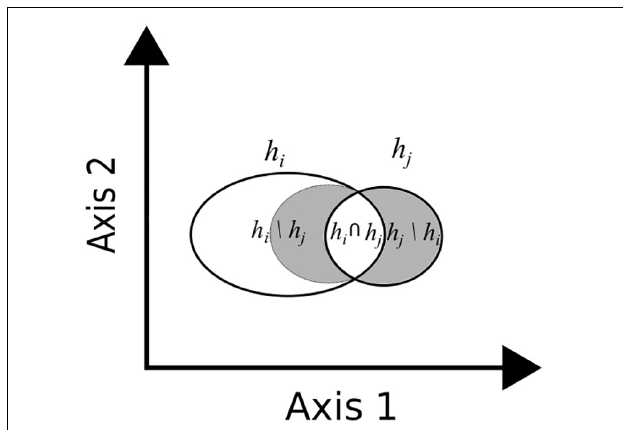
FIGURE 1 | Diagram showing hypervolume partitioning in two dimensions. The overlap between hypervolumes hi and hj is given by the interception ( hi ∩ hj ) and the differentiation ( hi (cid:49) hj ) is given by the sum of their unique fractions, hi \ hj and hj \ hi . Note that: hi (cid:49) hj = 2min( hi \ hj , hj \ hi ) + | hi \ hj – hj \ hi |, where 2min( hi \ hj , hj \ hi ) corresponds to the differentiation due to the replacement of space (gray shaded area) and | hi \ hj – hj \ hi | refers to the net difference between both hypervolumes (white area in the hi \ hj